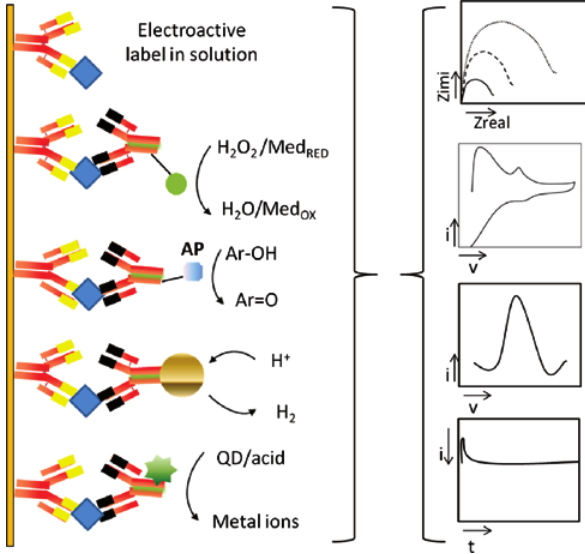
Figure 3: Different strategies for the detection of electrochemical